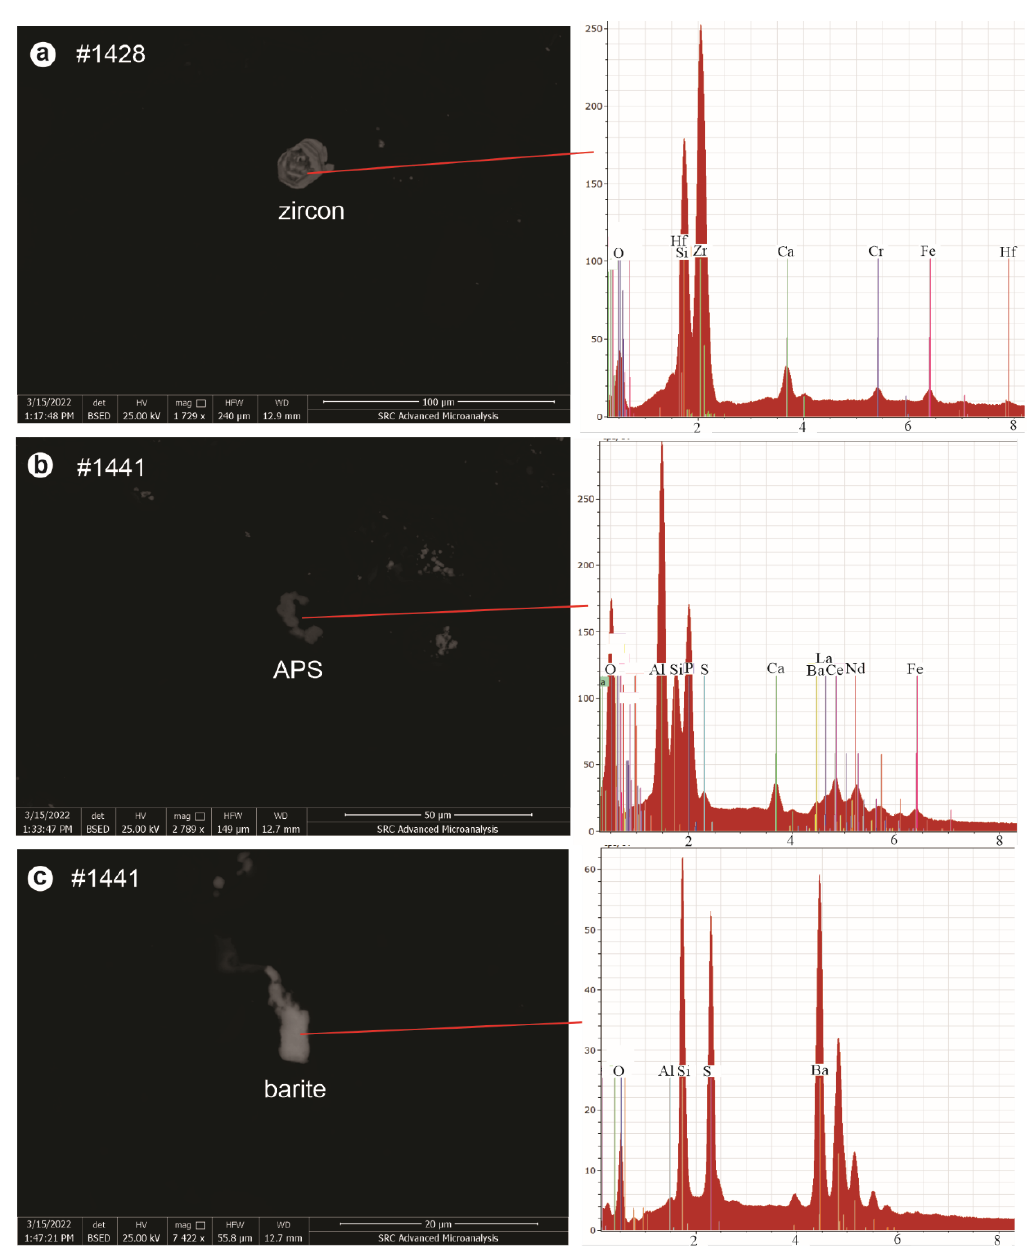
Figure 9. BSE images and EDS spectrums of selected spots in sandstone sample indicating zircon ( a ), APS ( b ) and barite ( c ).